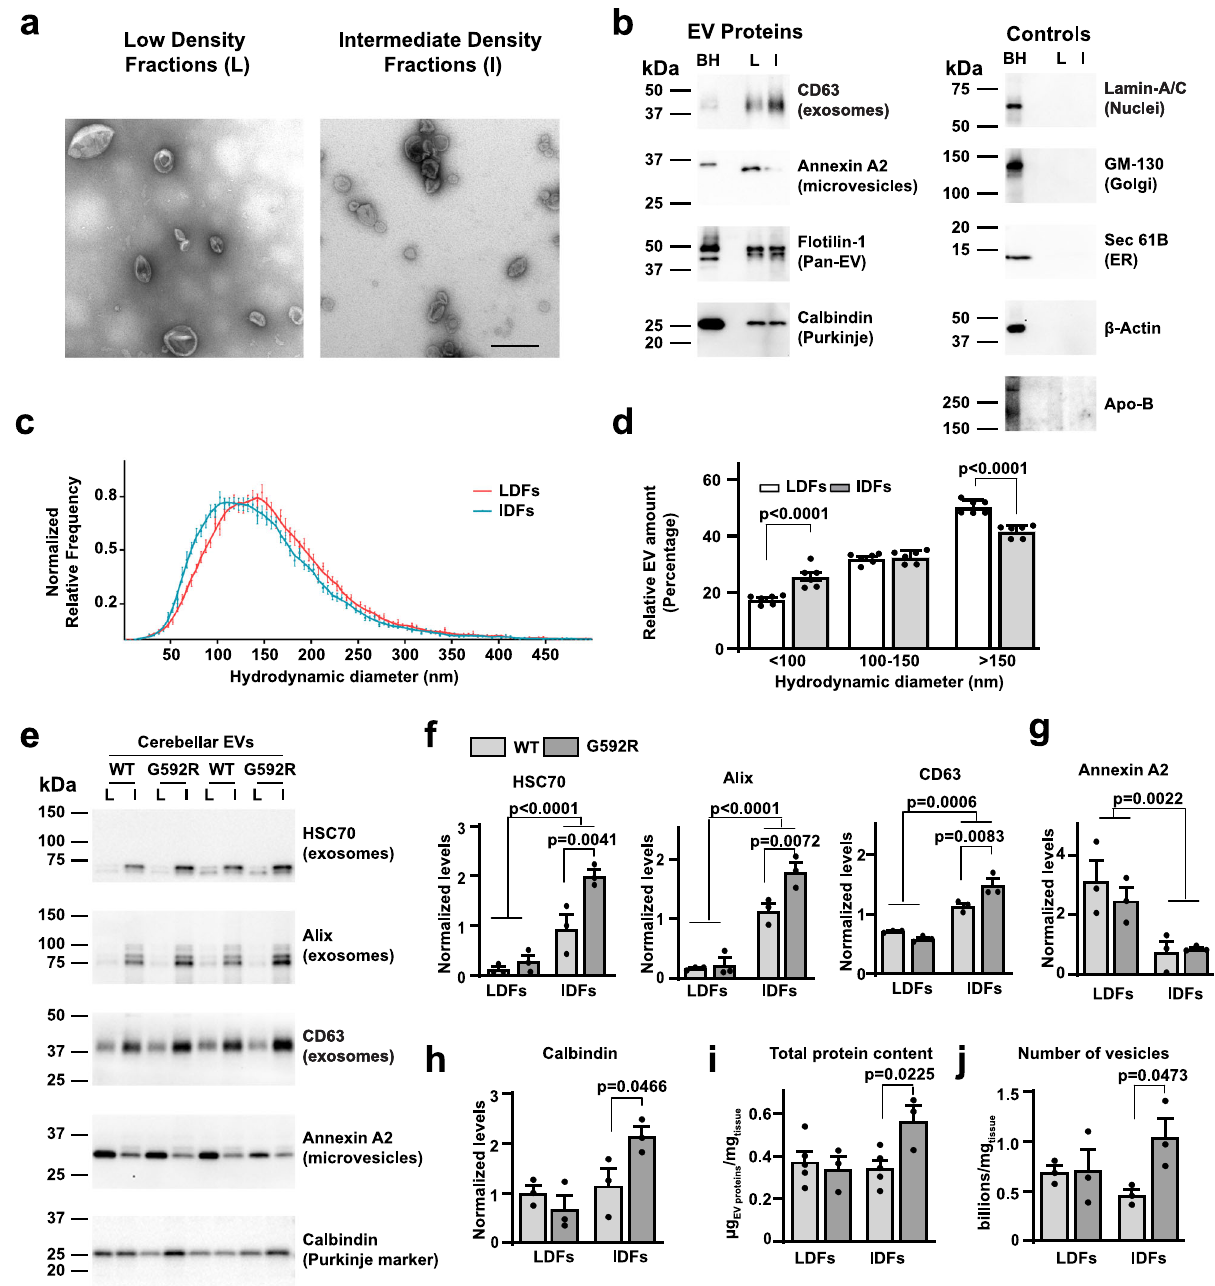
Fig. 9 The Kv3.3 G592R mutation promotes release of exosomes into the extracellular space. a Representative transmission electron microscopy photomicrographs of low density fraction (LDF) and intermediate-density fraction (IDF) extracellular vesicles (EVs) isolated from the cerebellum of a wild type mouse. Scale bar: 500 nm. Images are representative of ten images taken of each of the sets analyzed. b Representative Western blot analyses of LDF EVs (L) and IDF EVs (I) compared to the cerebellar homogenate (BH). c Nanotrack analysis (NTA) of the hydrodynamic diameter of the EVs found in LDFs and IDFs. The curve is normalized to the mode of each distribution ( fi ve independent isolations. d Quanti fi cation of particles in LDFs and IDFs by NTA that are found within the size bins shown in the graph. Data are plotted as percentage of total number of EVs. Five independent isolations. e Representative Western blot analyses of EVs isolated from cerebella of wild type and G592R Kv3.3 mutant mice. LDFs (L) and IDFs (I) were isolated from cerebella of two mice of the same genotype and these were combined and tested for the markers shown. Two independent experiments are shown in the blot. f – h quanti fi cation of data in e . The densitometric quanti fi cation was performed on three independent experiments, representative of six mice per genotype. BCA protein assay ( i ) and total particle count as estimated by NTA ( j ) of LDFs and IDFs in wild type and G592R Kv3.3 mice. Values were normalized to the cerebellum wet weight ( fi ve independent isolations for wild type and three independent isolations for mutant mice, corresponding to ten and six mice, respectively. All data are shown as a mean ± SEM. Statistical test used in all fi gures: Two-Way ANOVA with Sidak ’ s multiple comparisons test). Source data and uncropped Western blots are provided as a Source Data fi